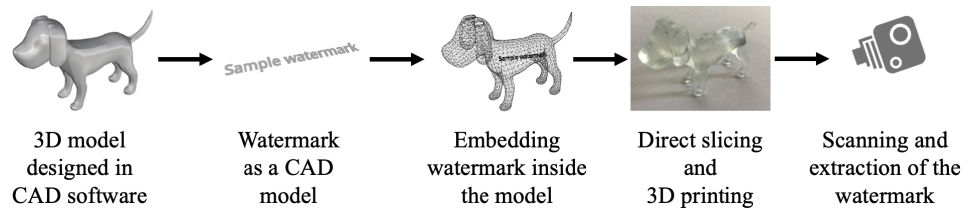
Figure 4. Design and manufacturing pipeline for watermarking inside the